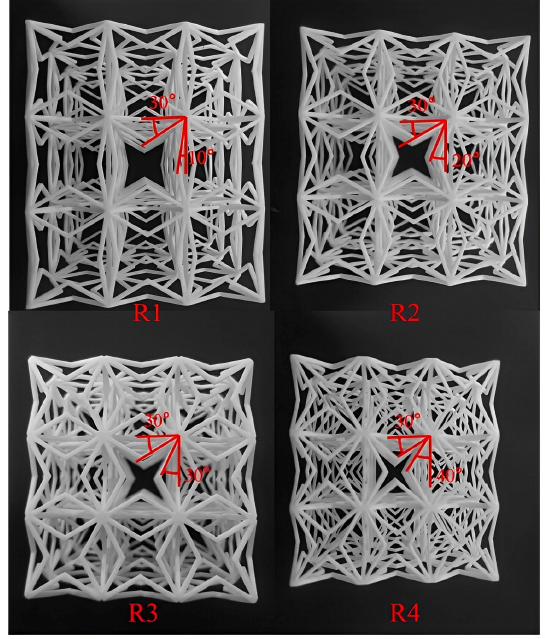
Figure 9. 3D ZPR honeycomb specimen for compression test.